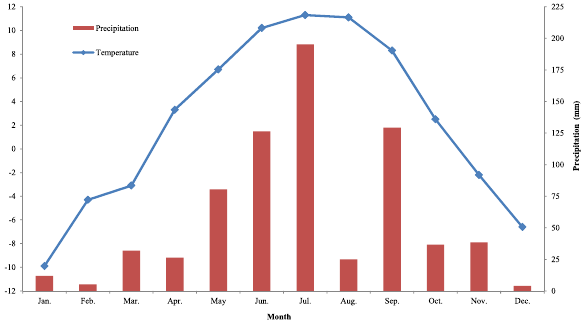
Figure 1. Total precipitation (mm) and monthly mean temperature (°C) at the study area in 2011. The data are from the Zoigê climate